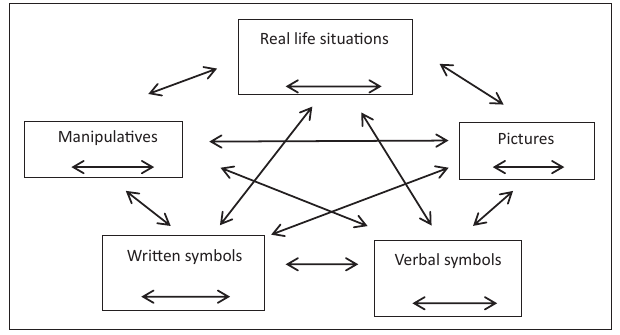
FIGURE 1: A diagrammatic representation of the translation model.